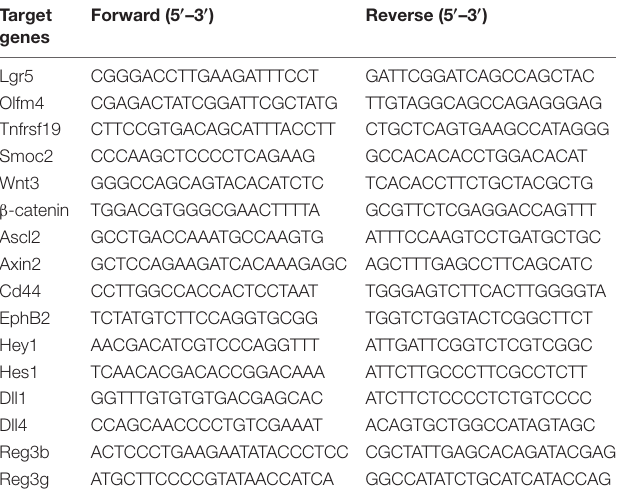
TABLE 1 | The gene-specific primers for the q-PCR. Target Forward (5 (cid:48) –3 (cid:48) ) Reverse (5 (cid:48) –3 (cid:48) genes